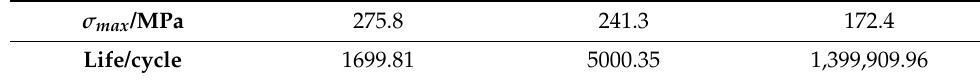
Table 5. Fatigue test data of 7075 aerospace aluminum alloy.